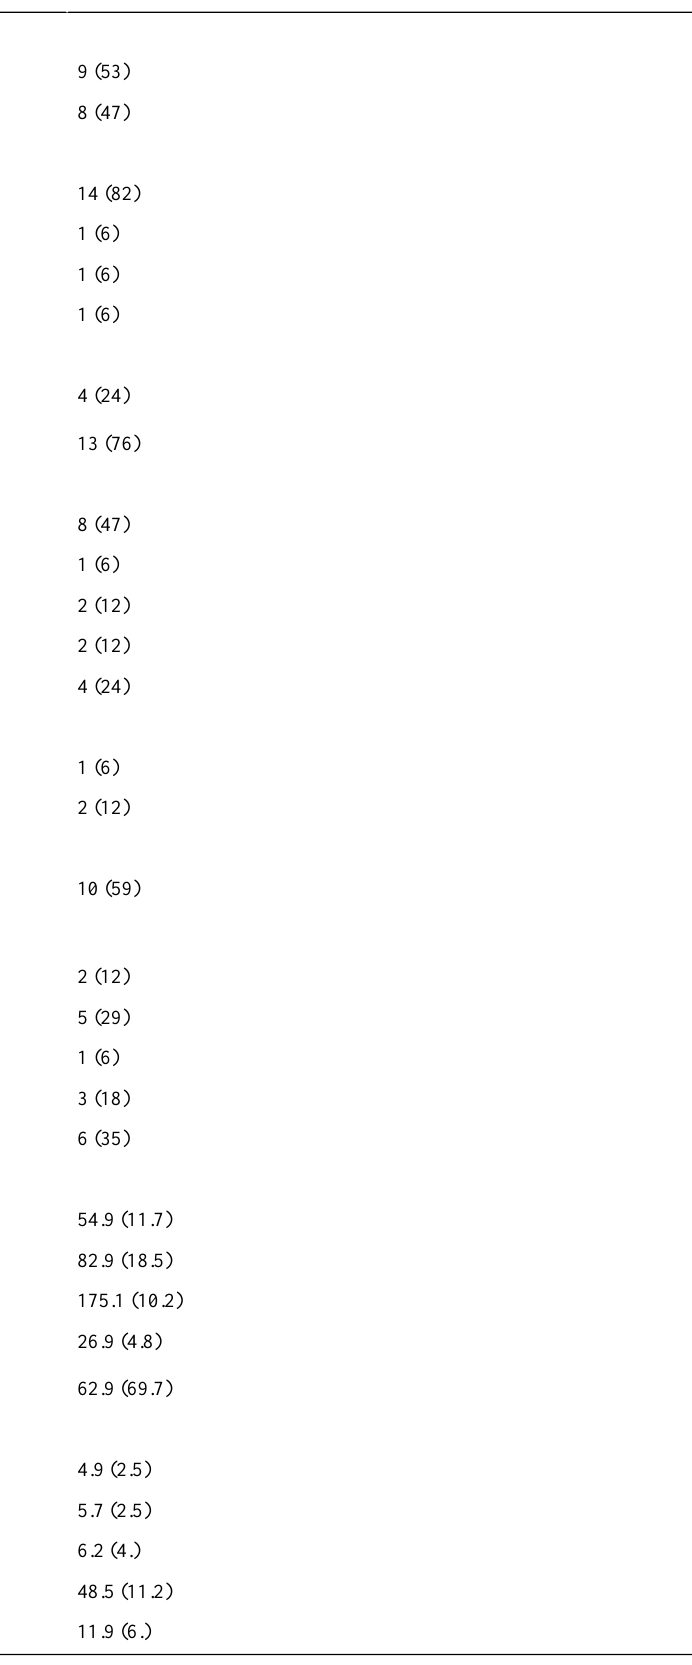
Table 1. Participant demographic characteristics and questionnaire scores